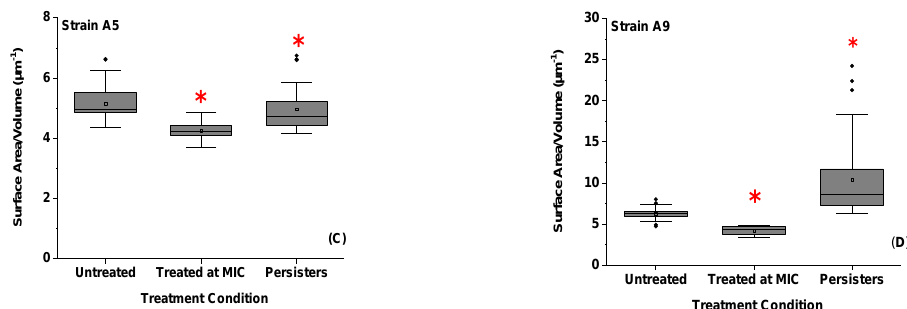
Figure 4. Summary of ( A , B ) the average surface area and ( C , D ) the surface area to volume ratio for MDR E. coli A5 and A9 untreated cells, cells exposed to ampicillin at MICs and persister cells exposed to 20xMIC, respectively. ( A , C ) For Strain A5, 45, 30, and 34 cells were probed, respectively, whereas, for Strain A9, 38, 45, and 39 cells were plotted, respectively. * Values are statistically significant between the untreated and treated cells, p < 0.001, n = 3 independent cultures.